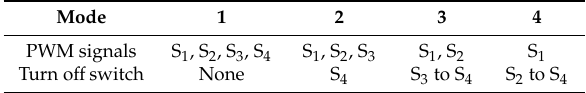
Table 2. Active switches involved in the modes of the converter.